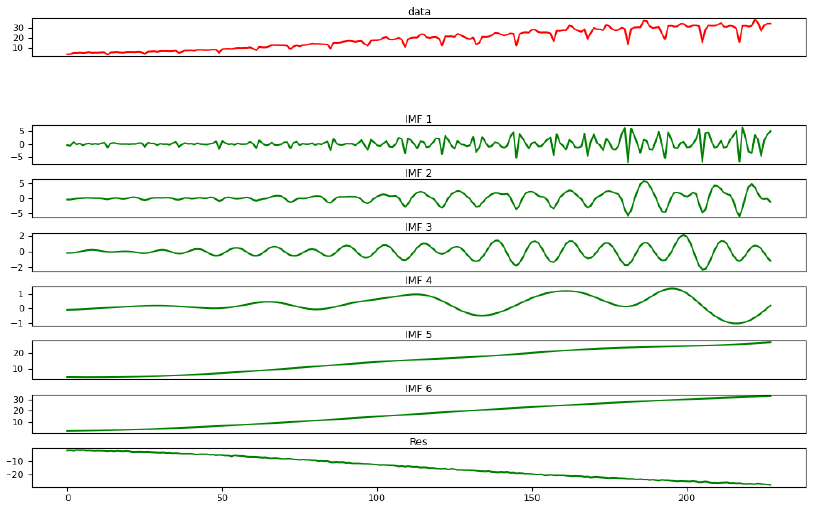
Figure 6. EEMD decomposition results of the annual monthly load training and validation sets. Table 1. The zero-crossing rate of IMFS for monthly load training and validation sets. IMF1